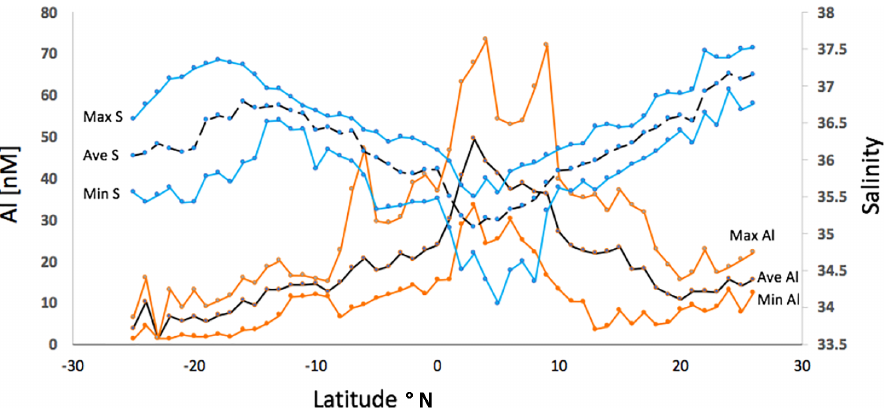
Figure 5. Compilation of aluminium (Al) data for the tropical Atlantic Ocean. Solid and dashed lines represent minimum, maximum, and average Al (filtered and unfiltered) and salinity for several cruises in different seasons and years. For each degree in latitude available Al data have been averaged. For specific seasons and specific references to a dataset please refer to Fig.